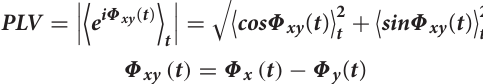
interval for the ERD/ERS calculation was taken from 0 to 1 s for each epoch. After performing the artifact removal mentioned above, wavelet transformation was applied to analyze the law of EEG signal energy changing with frequency and time. The single time–frequency map under the same task is superimposed and averaged to obtain the final time–frequency